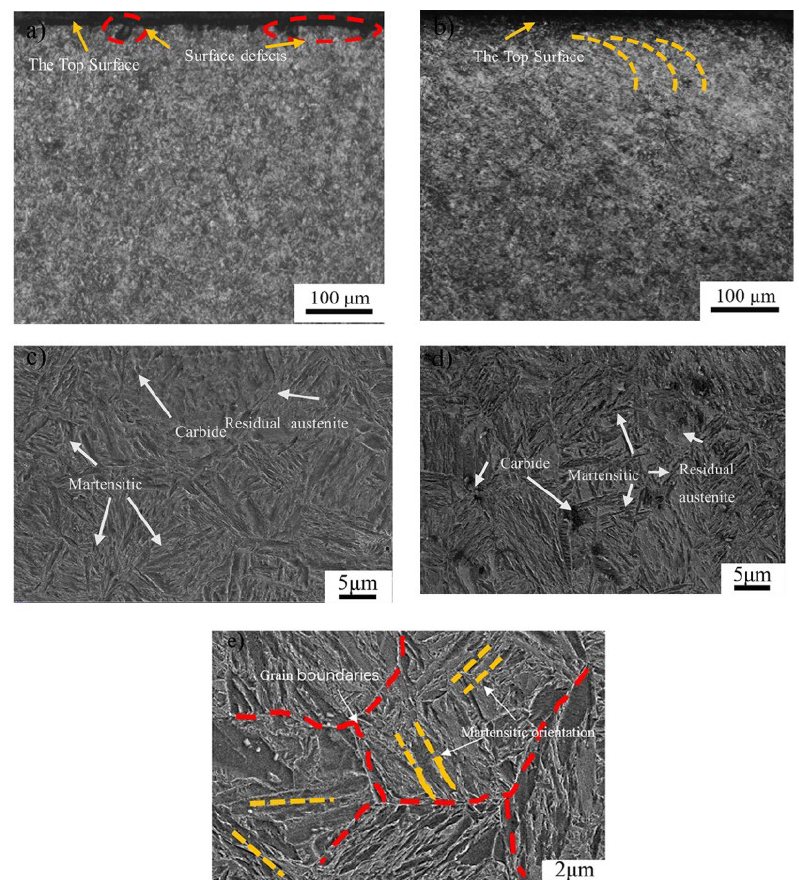
Figure 7. Microstructure of the surface layer of axial steel before and after USRP. (a) Untreated microstructure (OM); (b) USRP treated microstructure (OM); (c) Untreated microstructure (SEM); (d) and (e) USRP post microstructure